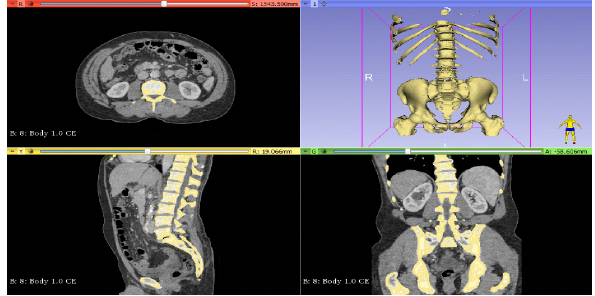
Figure 4: Fully automated segmentation for bone in 3D Slicer